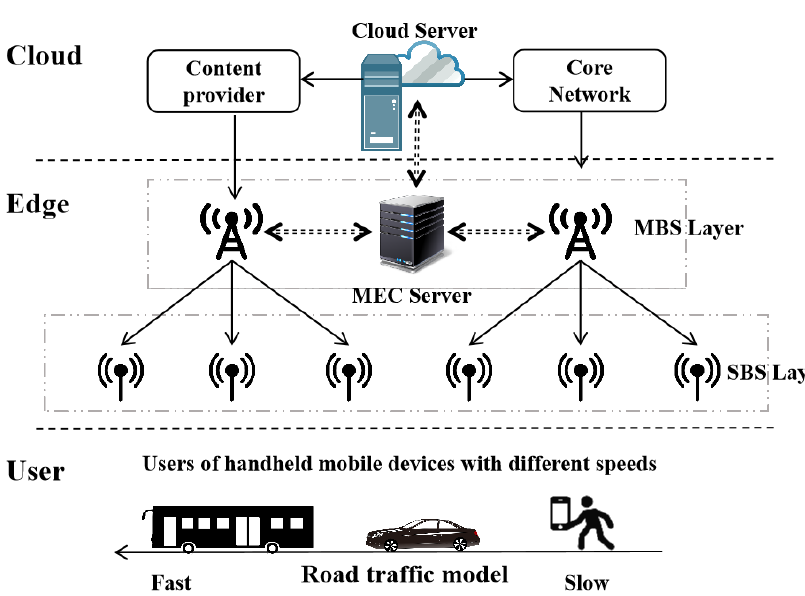
Figure 2. Three-layer structure of a mobile edge cache network. Cloud Layer: Mainly composed of a central cloud server, and the video content is provided by the content provider of the core